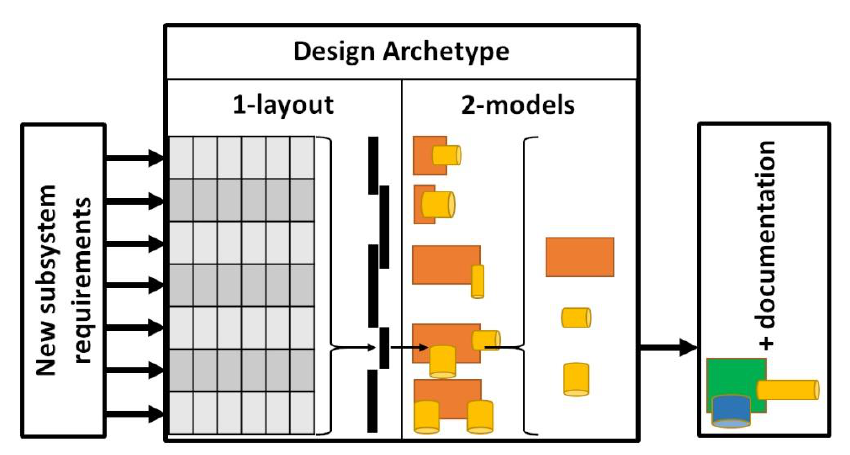
Figure 1. Design archetype as a top-down design tool.